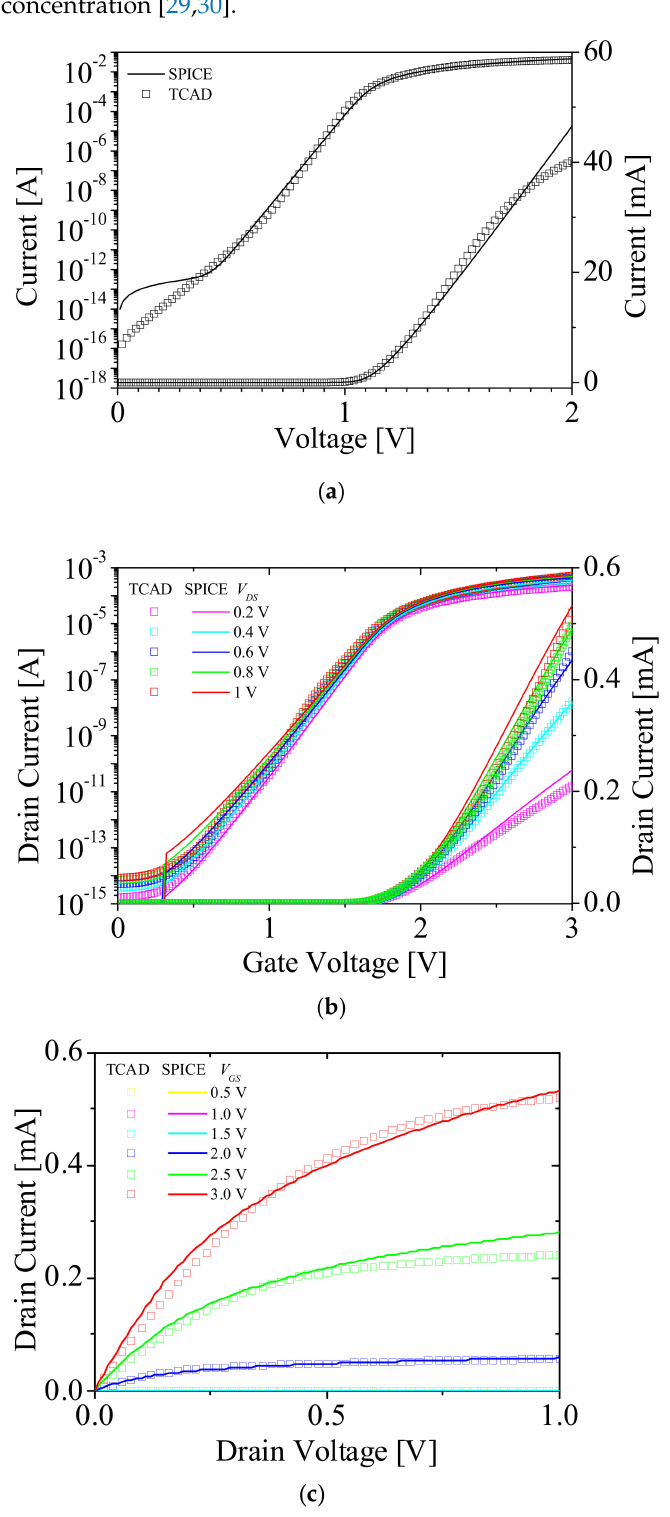
Figure 4. Diode parameter fitting data ( a ) and metal–oxide–semiconductor field–effect transistor (MOSFET) parameter fitting data for ( b ) I DS - V GS characteristics, and ( c ) I DS - V DS